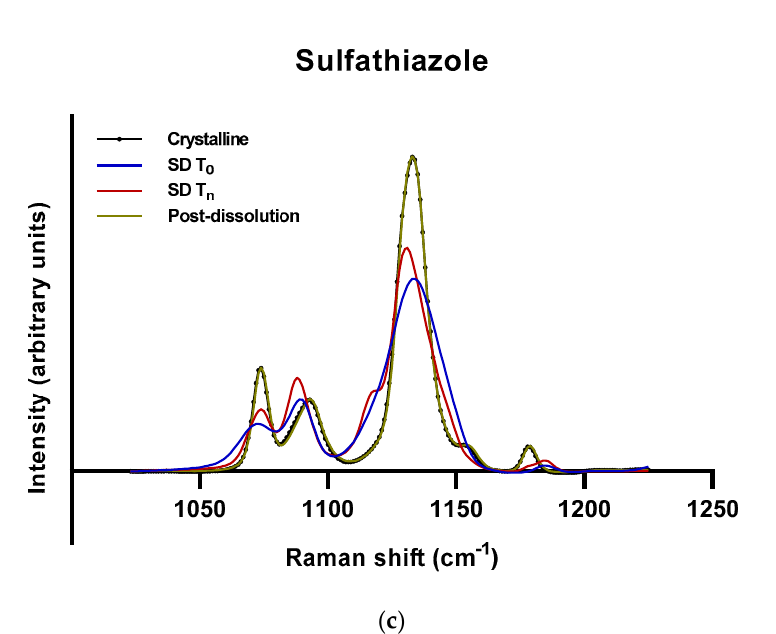
Figure 6. Raman spectra of different samples of ( a ) hydrochlorothiazide, ( b ) hydrocortisone, and ( c ) sulfathiazole. The samples represented are unprocessed crystalline (black circle); fresh spray-dried/complete amorphous, SD T 0 (blue); spray-dried crystallized at different time points at 75% RH, SD T n as indicated in Table 1 (red); and post-dissolution of SD T 0 (olive).